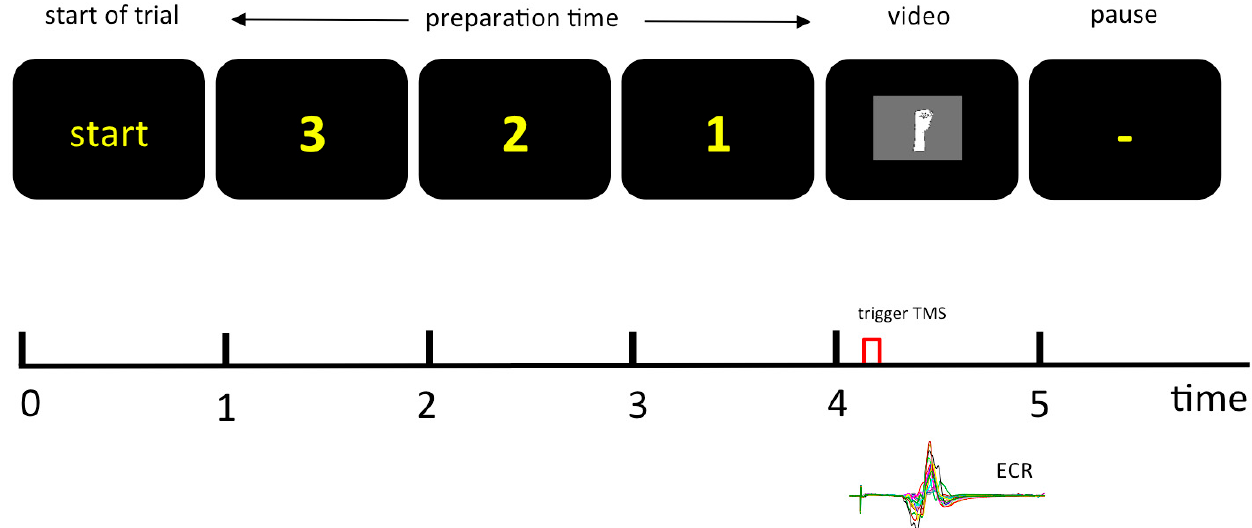
Figure 1. Schematic representation of the experimental set up shows the screen presentation for the different experimental conditions of sensory input. After the presentation of the start signal, there was a 3-s delay before the hand (VIS, VIS & KIN) was presented. In the kinaesthetic only condition (KIN), a black screen was shown instead. In the control condition (CC), a small fixation cross was shown. TMS was applied in the zero position during moving the wrist from the flexed to the extended position. The EMG (electromyogram) of the extensor carpi radialis muscle (ECR) was measured.